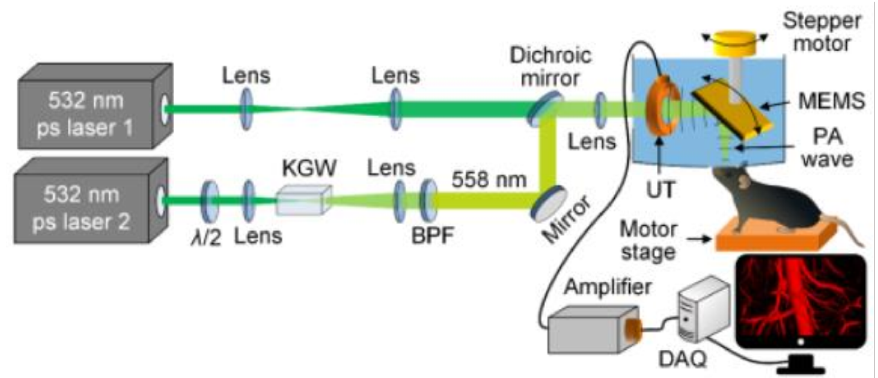
Figure 2. Schematic of a functional OR-PAM system without acoustic impedance mismatch: KGW, KGd (WO4) 2 crystal; λ /2, half-wave plate; BPF, band-pass filter; DAQ, data acquisition unit; and UT, US transducer (Reprinted from Ref.